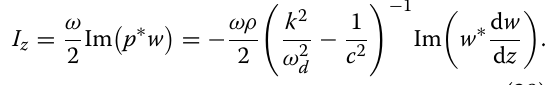
Using Eqs. (25) and (28), for the time-averaged verti- cal component of the power flux density in a monochro- matic wave we find